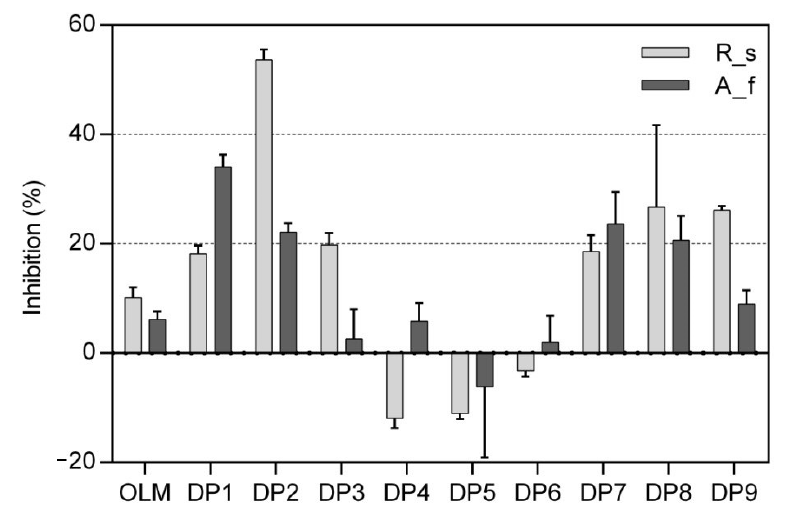
Figure 3. The toxicity data of olmesartan acid (OLM) and its byproducts (DP1–DP9) with 72 h R. subcapitata (R_s) and A. fischeri (A_f).